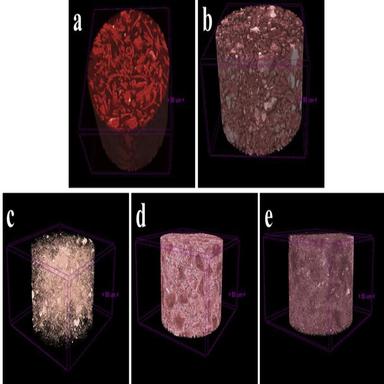
Micro-CT images of (a) the original larch sawdust, (b) liquefied larch sawdust, (c) LEC-800, (d) LEC-900 and (e) LEC-1000.